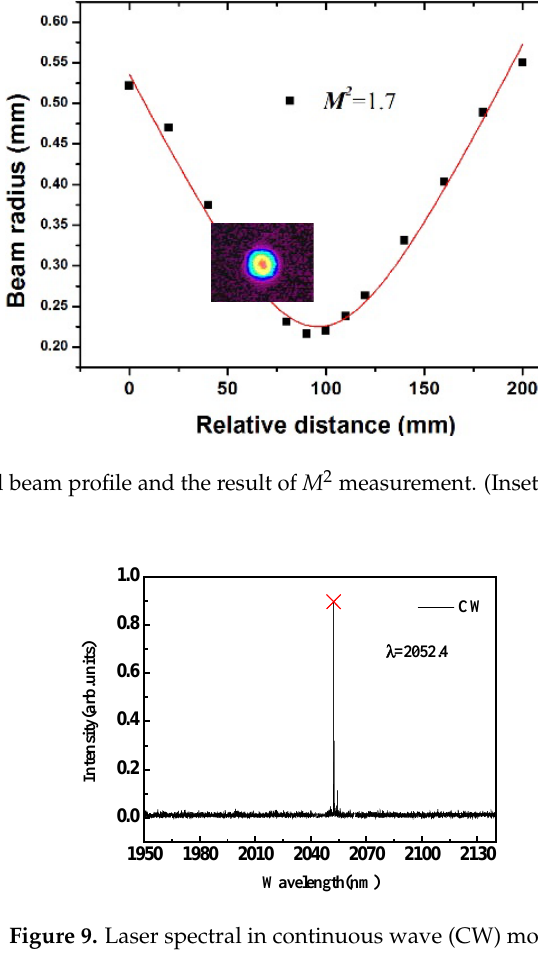
Figure 9. Laser spectral in continuous wave (CW) mode.